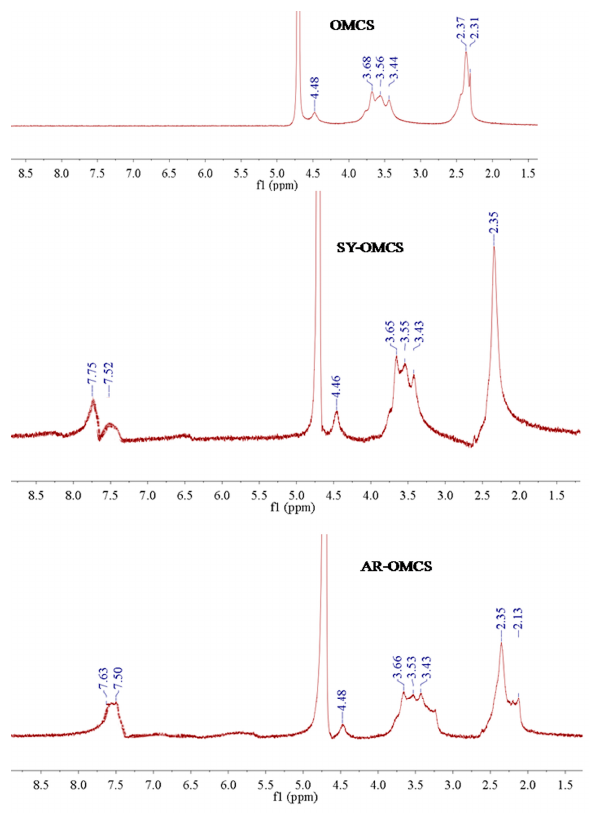
Figure 2. 1 H-NMR spectrum of OMCS and prepared polymer dyes.